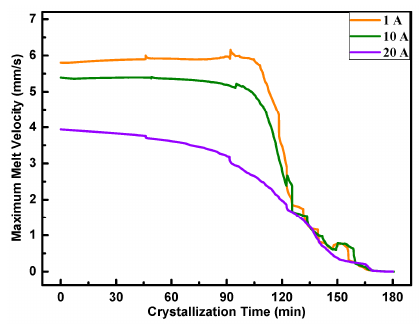
Figure 6. The value of the maximum melt convection velocity in the silicon melt.